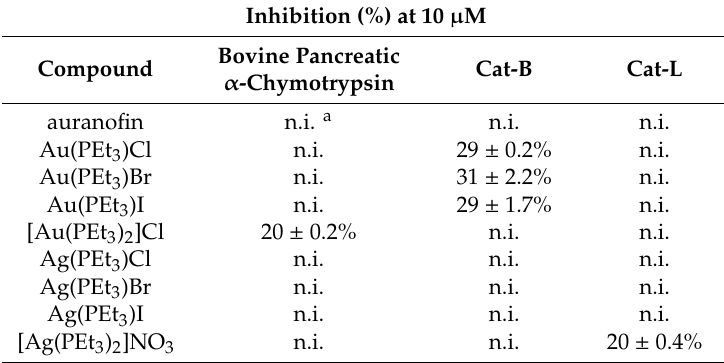
Table3. Screeningat10 µ Mofthepanelcompoundsfortheinhibitionofbovinepancreatic α -chymotrypsin, human Cat-B and Cat-L. Inhibition includes standard deviation from three independent experiments, each performed in